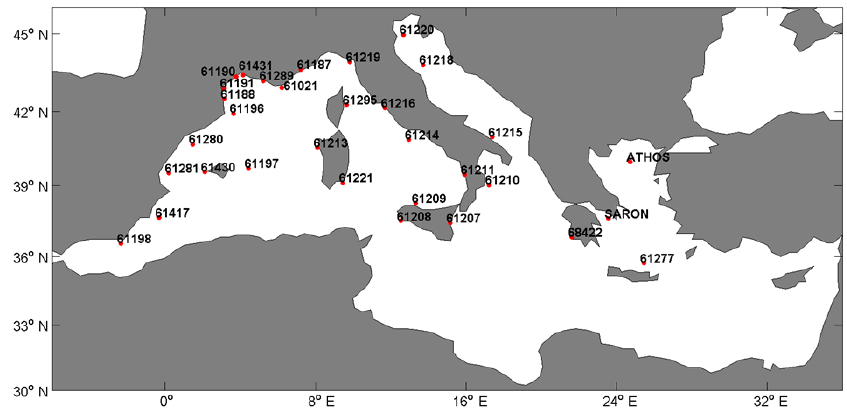
Figure 2. Wave buoys’ location and unique ID